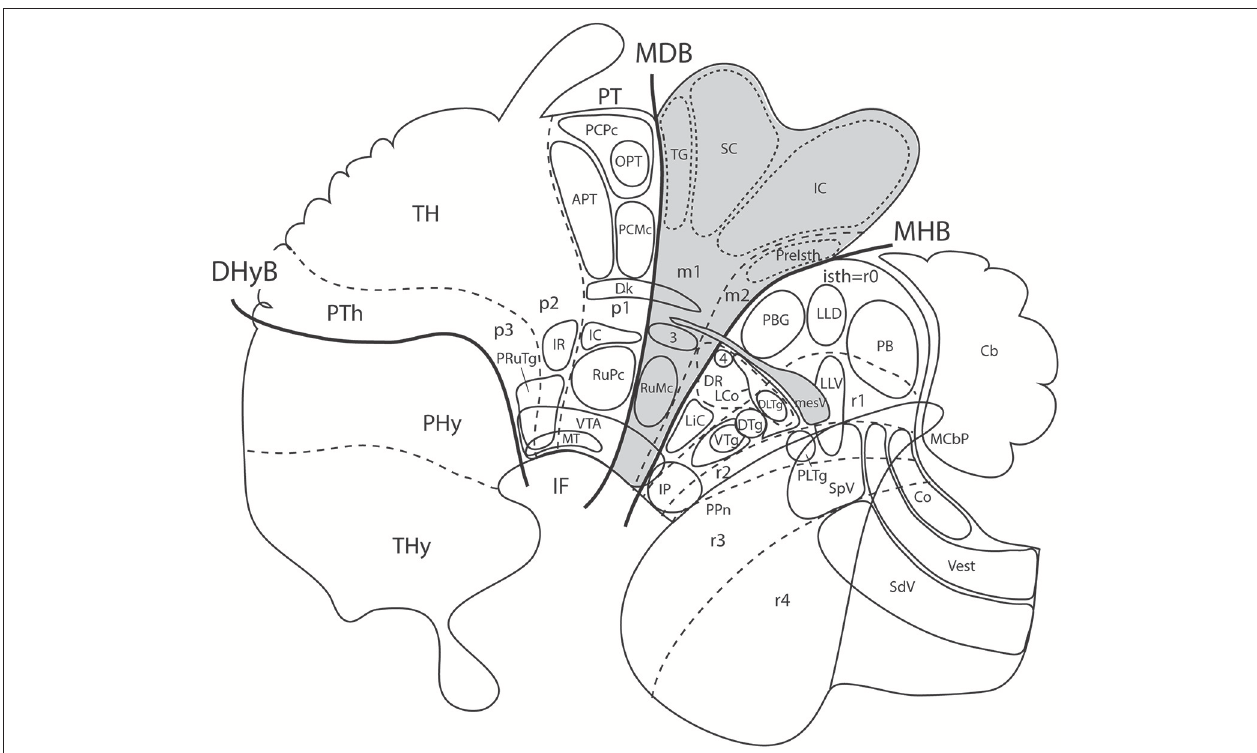
FIGURE 8 | Schema from Puelles (2016) (modified from those in Figure 7 ; no copyright permission required) showing truly mesencephalic centers (gray background) according to the prosomeric model, as opposed to neighboring diencephalic or rhombencephalic (prepontine) formations that have been implicated in erroneous ascription to the midbrain within classic neuroanatomic usage inspired in the columnar model. For specific ascriptions to the isthmic neuromere (r0), see Watson et al. (2017) . The trigeminal mesencephalic nucleus is thought to originate in the midbrain and partly migrate into the prepontine hindbrain along the mesV tract. The